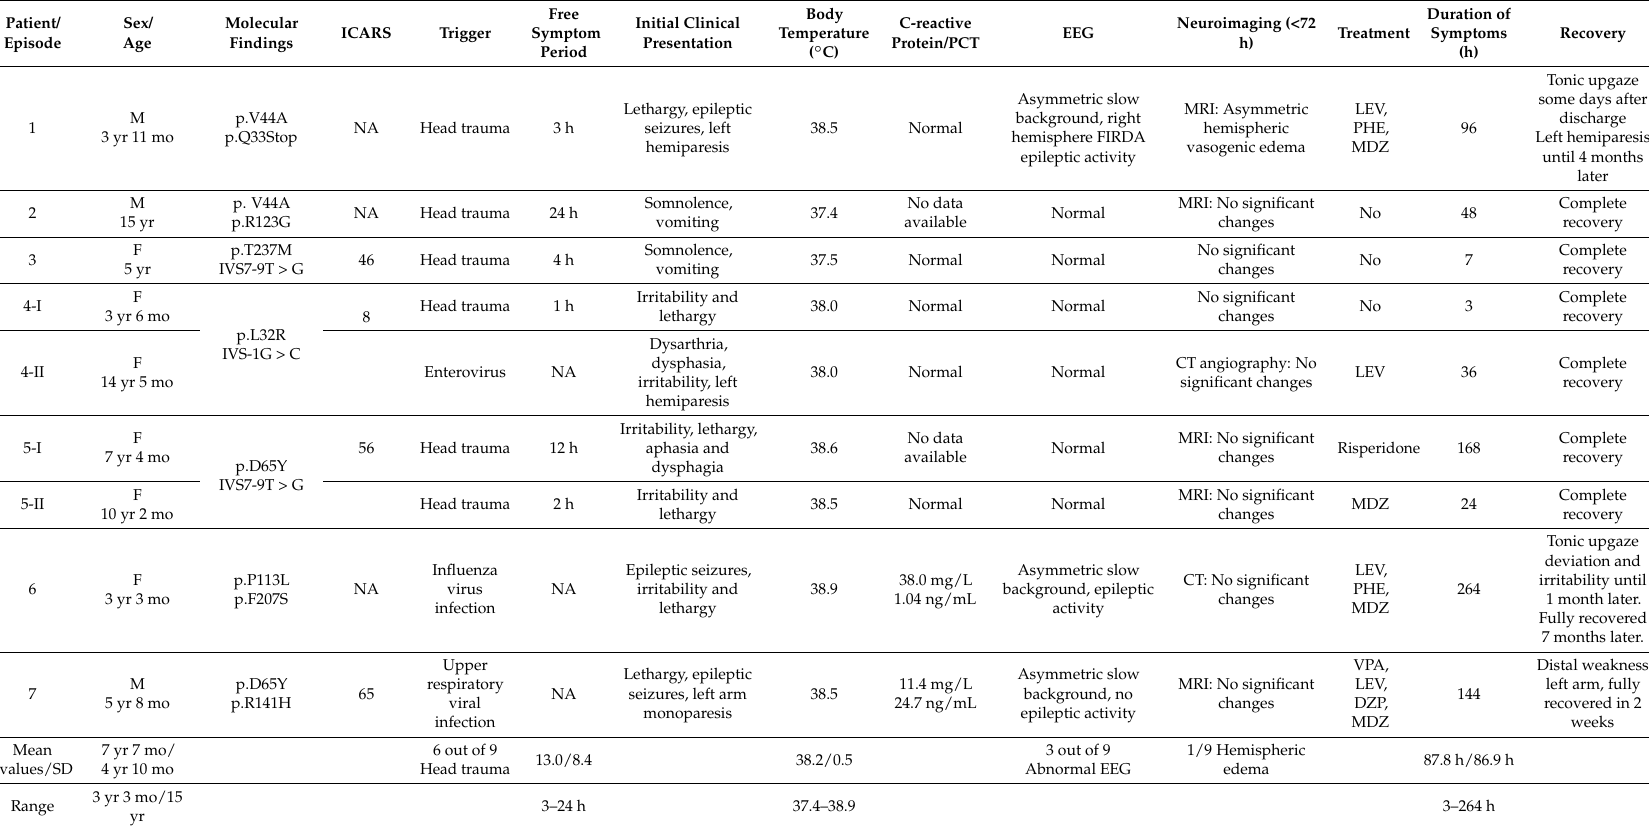
Table 1. Molecular, clinical, electrophysiological and neuroimaging details from stroke-like